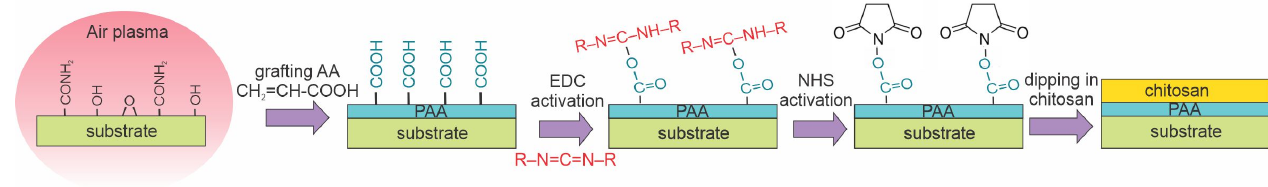
Figure 12. A method for immobilizing a chitosan film using the following steps: formation of func- tional groups by exposure to air plasma, grafting with acrylic acid, optional application of car- bodiimide chemical coupling, and dipping in acidic aqueous solution of chitosan.